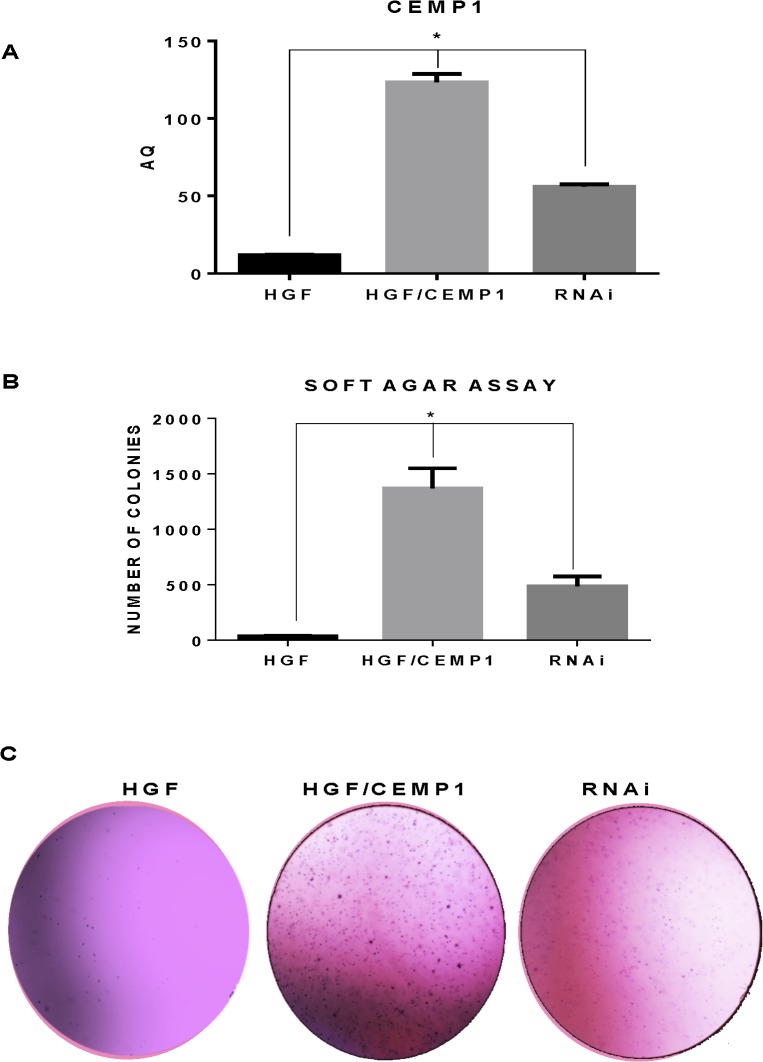
CEMP1 induces anchorage-independent growth in HGF cells.Cells were plated in a soft agar assay and the number of colonies was evaluated 21 days after the seeding. Representative plates of HGF, HGF/CEMP1 and HGF/CEMP/RNAi are presented. RT-qPCR showed that RNAi against CEMP1 decreased its expression in more than 50% at transcriptional level (A). All soft agar assays were performed in triplicates, and the mean ± standard deviations are presented (B and C).